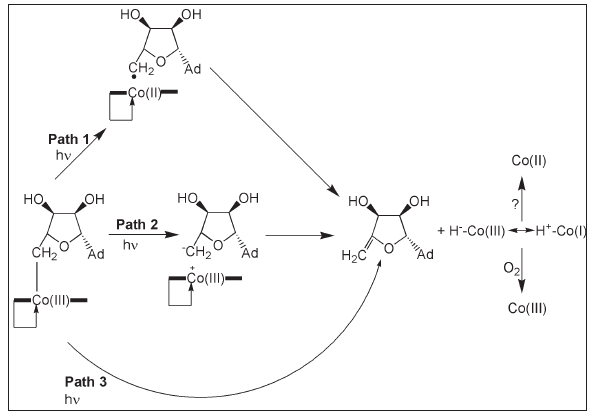
Scheme 3: Paths proposed for CarH